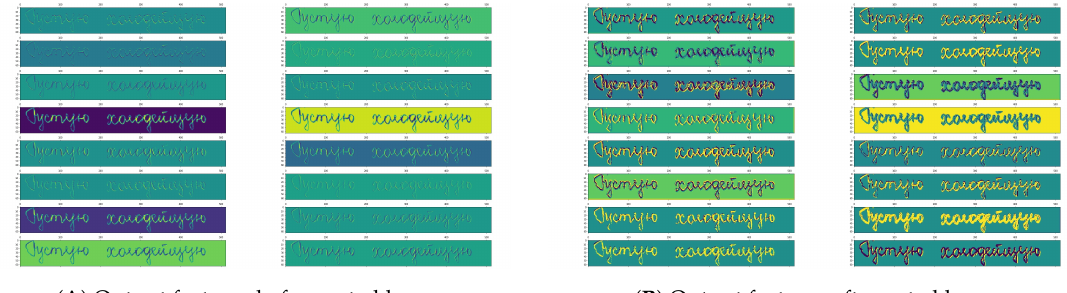
Figure 2. Visualization of the feature of a convolutional layer and gate layer. The gate layer looks at the vector feature’s value at the given position and the adjacent values and determines if it should be held or discarded at that